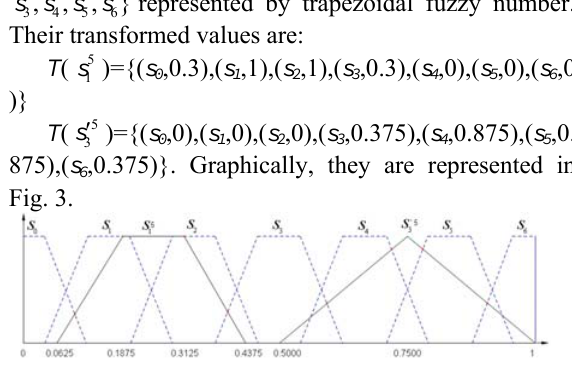
s and 5 s  are transformed into a fuzzy 1 3 set in S T